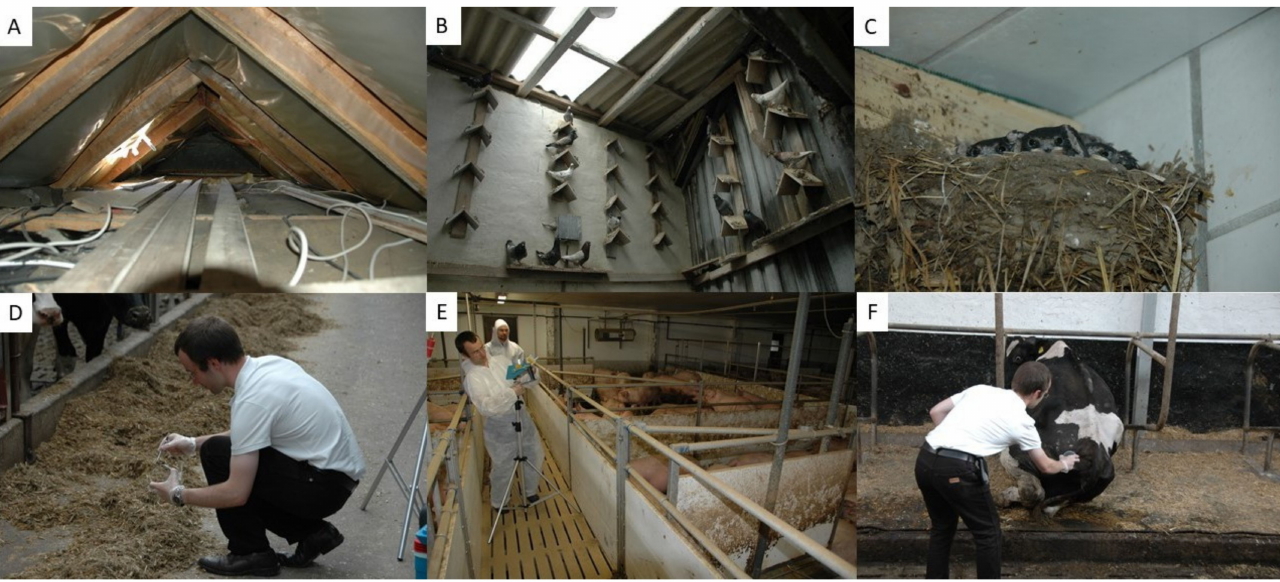
Figure 2. Illustration of the sampling sites and sample acquisition. ( A ) Attic. ( B ) Pigeon loft. ( C ) Bird nest within the barn. ( D ) Sample acquisition of straw in the barn. ( E ) Airborne spore collection in the pigsty. ( F ) Direct assessment of surfaces with agar plates in the cow